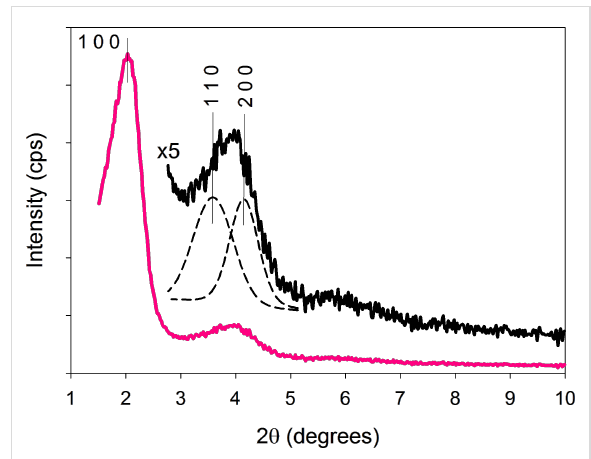
Figure 2: The low-angle XRD pattern of V-Ti/MCM-41.